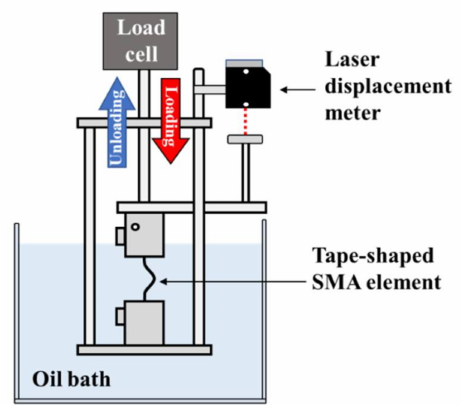
Figure 5. The schematic drawing of the buckling testing machine used in this study.